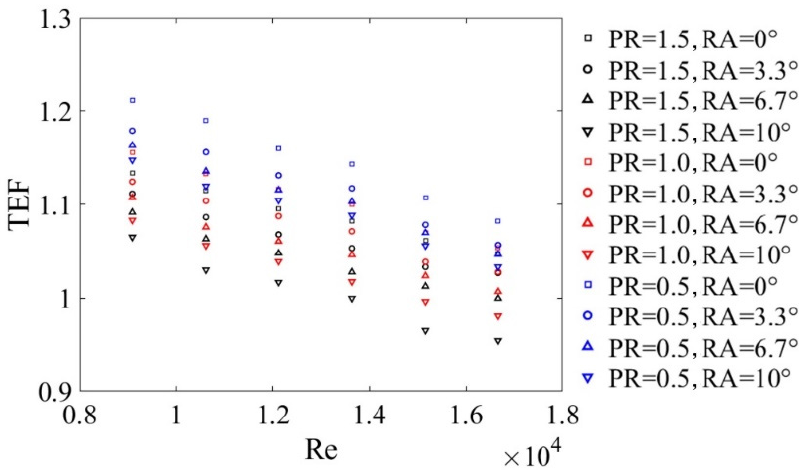
Figure 11. Effects of DWPVGs on the TEF for different PR and RA .